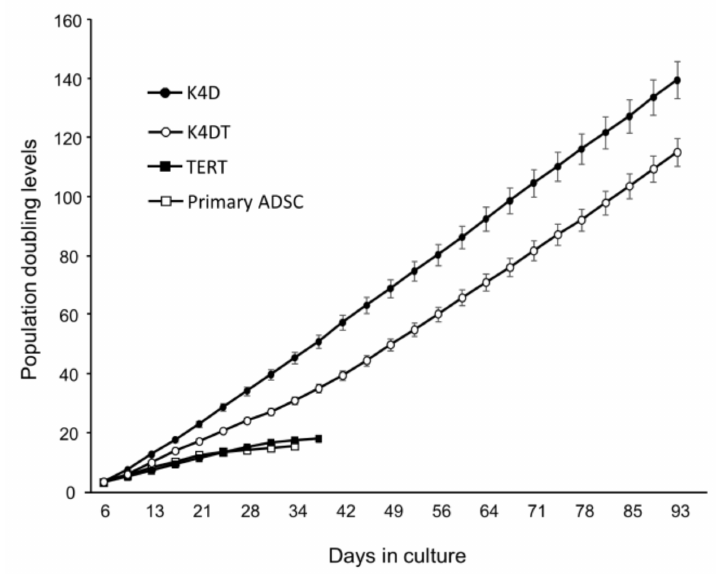
Figure 1. Growth curves of the primary ADSCs, and the ADSC-TERT, ADSC-K4DT, and ADSC- K4D cells. Population doubling levels (PDLs) were calculated for each cell line over time. PDL represents the sum of the population doubling (PD) values obtained when the cells were passaged. The histogram represents the mean of the three independent experiments. Data are expressed as the mean ± standard deviation.